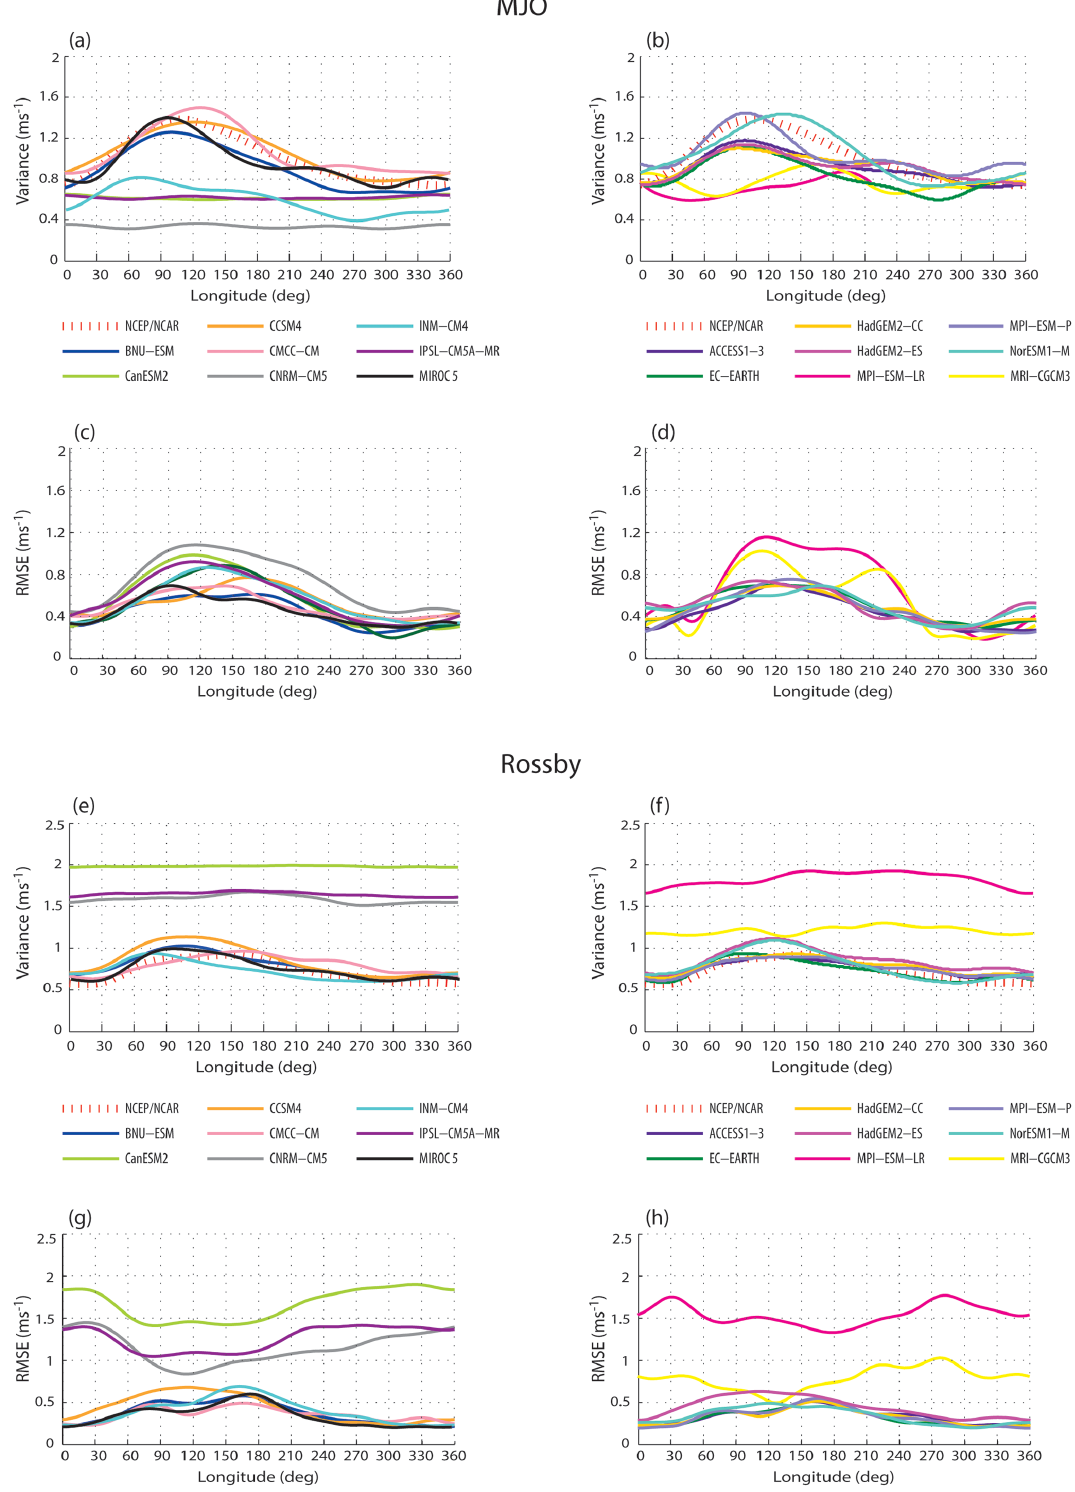
Figure 3. Variance (rms) of MJO (a, b) and Rossby waves (e, f) filtered U850 averaged between 15 ◦ N and 15 ◦ S for CMIP5 models and the NCEP/NCAR Reanalysis. Root mean square error (RMSE) between modelled and observed variance of MJO (c, d) and Rossby waves (g, h) averaged between 15 ◦ N and 15 ◦